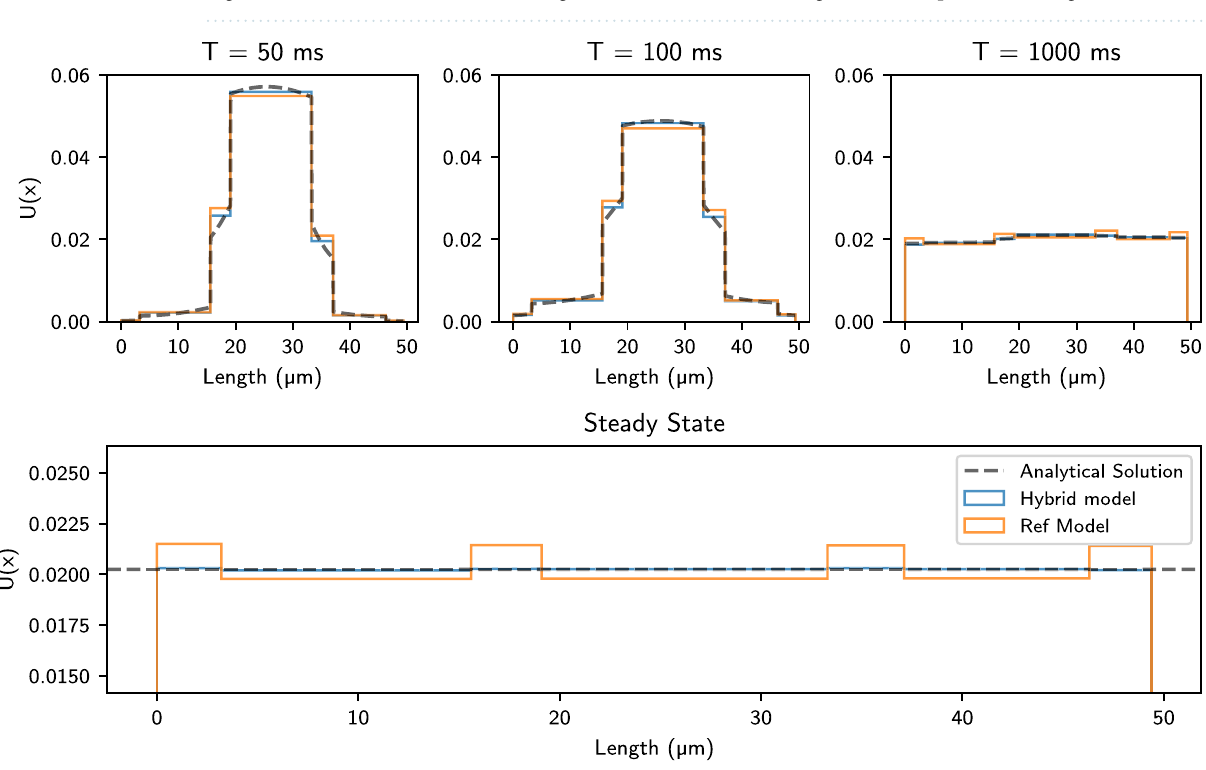
Figure 6. Illustration of the process of synthesising a 1D domain from histology data. Left figure: An example of a region of histology from a wide-field microscopy image. This is part of a large stack of histology slices obtained from the mesocardium of swine. Cardiomyocytes (red–purple) are cut perpendicular to their long axis. Extra-cellular space is white, while collagen is stained blue. Right figure: Distribution of cell sizes from automatic segmentation for the entire stack of images as well as manual labelling of a small representative region.